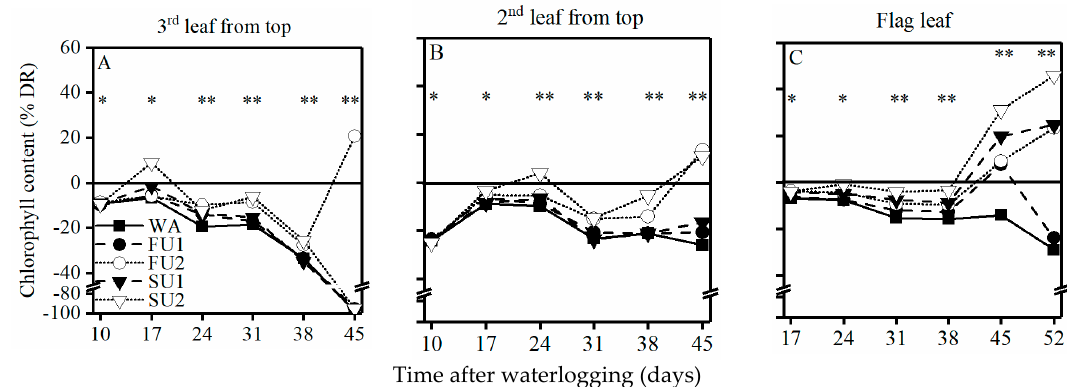
Time after waterlogging (days) Figure 3. Variation in chlorophyll content of ( A ) the 3rd leaf from the top, ( B ) the 2nd leaf from the top, and ( C ) flag leaf relative to the water drainage treatment (DR) for different remedial treatments after waterlogging. ns, *, and ** indicate the non-significant difference and the significant difference at p < 0.05 and p < 0.01, respectively, in the chlorophyll content after the water drainage treatment (DR), the waterlogging treatment (WA), and the remedial treatments (FU1, FU2, SU1, and SU2). Table 4. Correlation coefficients of spikelet fertility, kernels per spikelet, kernels per spike, and post- anthesis biomass with chlorophyll content of the top three leaves.